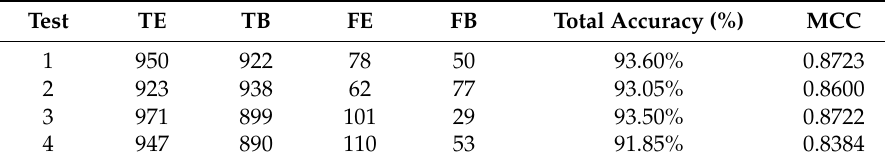
Table 3. Classification results and quality evaluations for test 1 to test